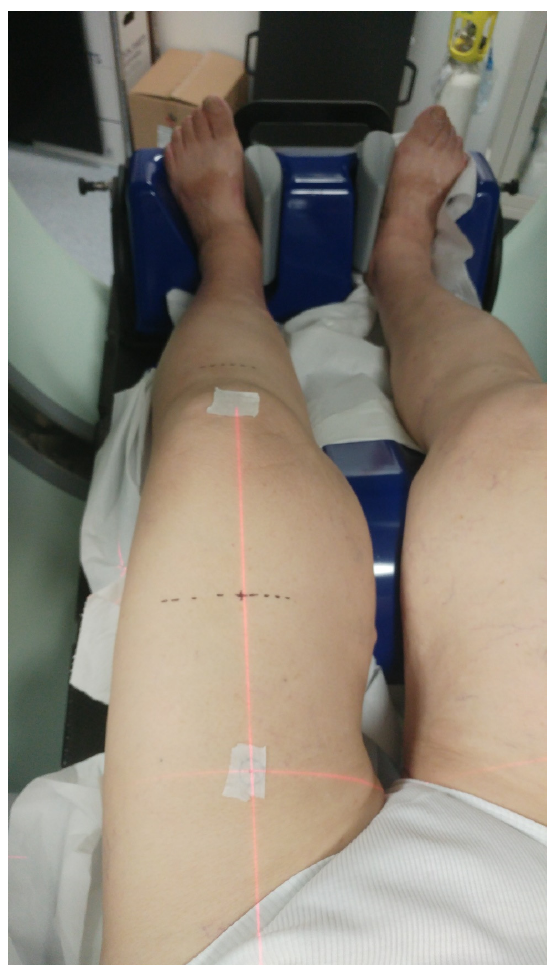
Figure 1. Patient positioning during CT simulation: legs and feet were immobilized by means of a ProSTEP device and landmarks were marked on the skin for isocenter determination.